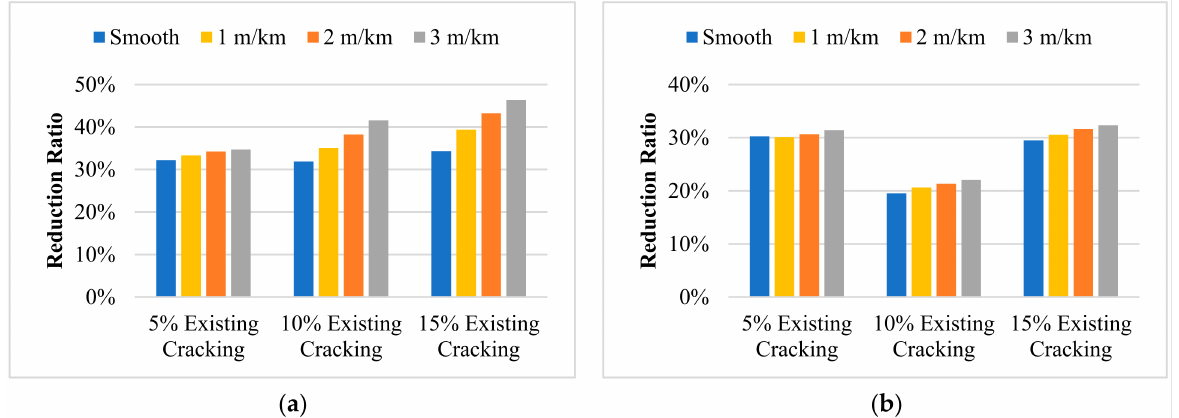
Figure 10. Impact of overweigh traffic on reduction ratio of pavement life, considering different percentages of existing fatigue cracking: ( a ) major highway; and ( b ) minor